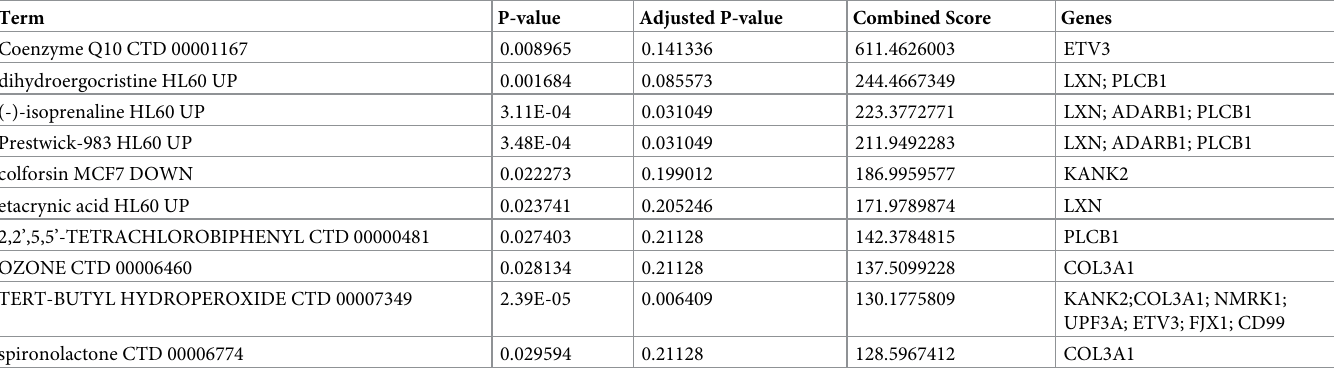
Table 1. Suggested top drug compounds for